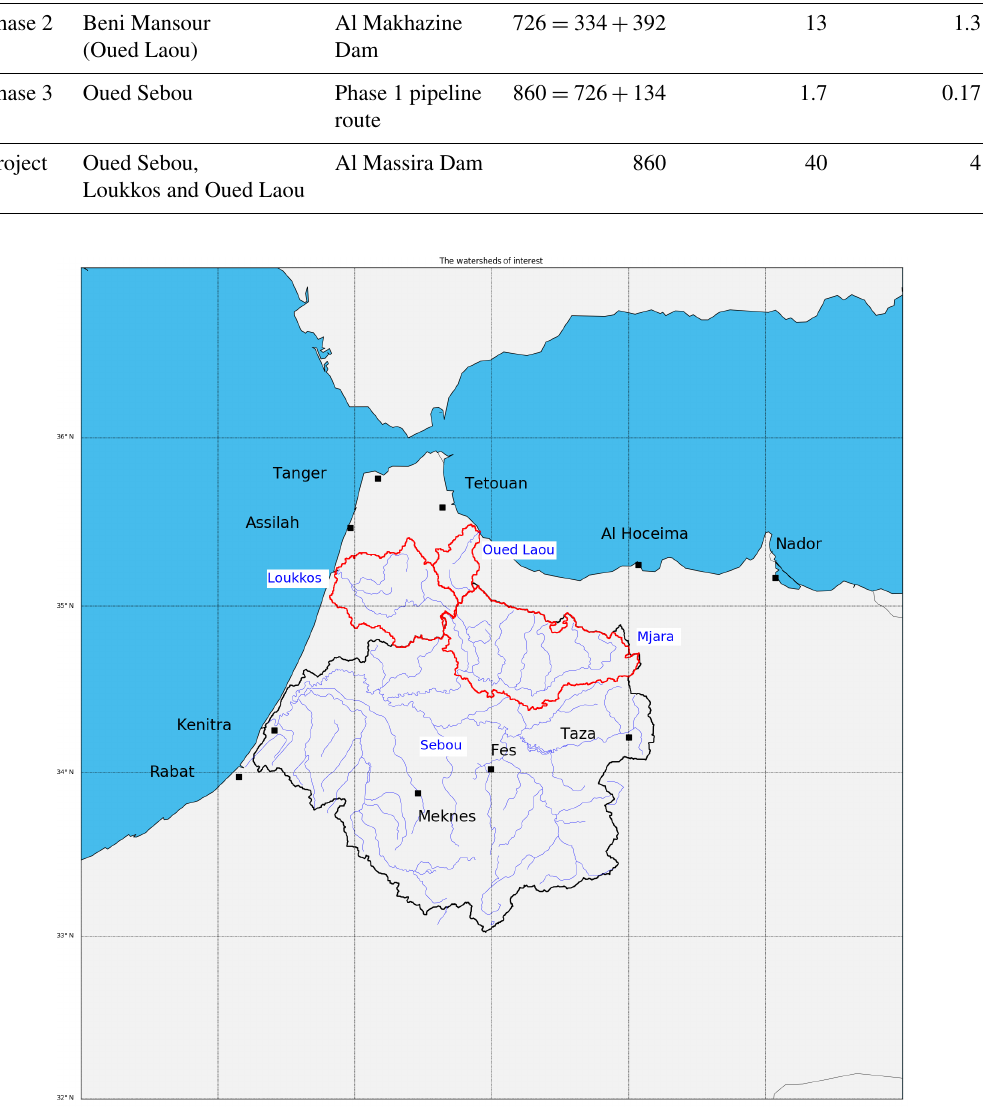
Figure 3. Watersheds of